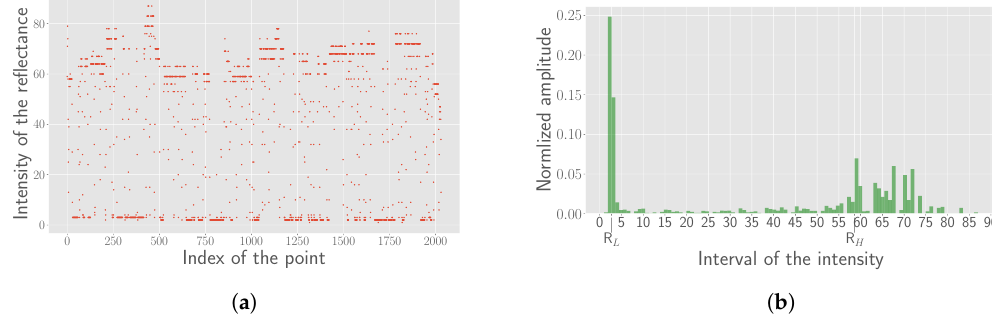
Figure 7. Estimated parameters for each frame. ( a ) Scatter diagram of the intensity for all points in the chessboard; ( b ) The histogram of the intensity. R L , R H can be found at the peaks of the two